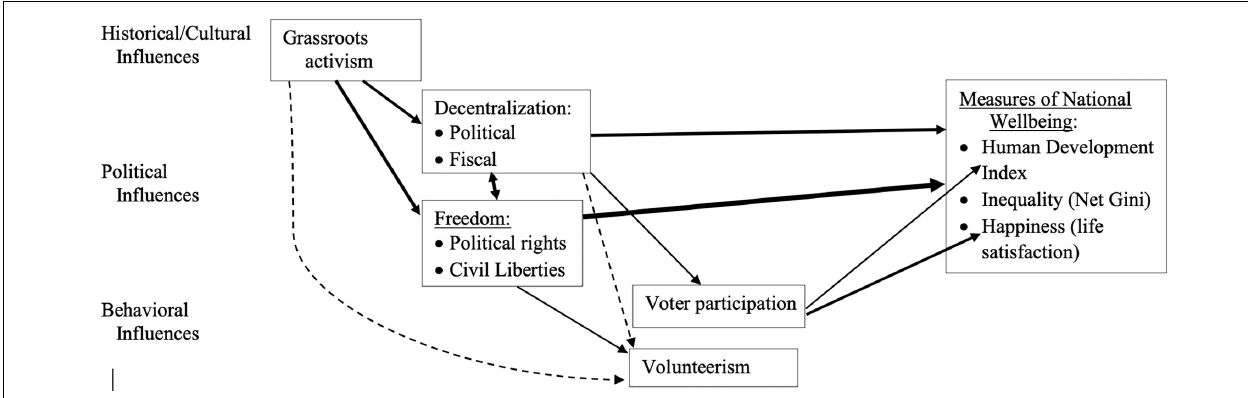
fiscal decentralization, voter turnout, and volunteer time were all statistically significant in the full final model ( Table 3